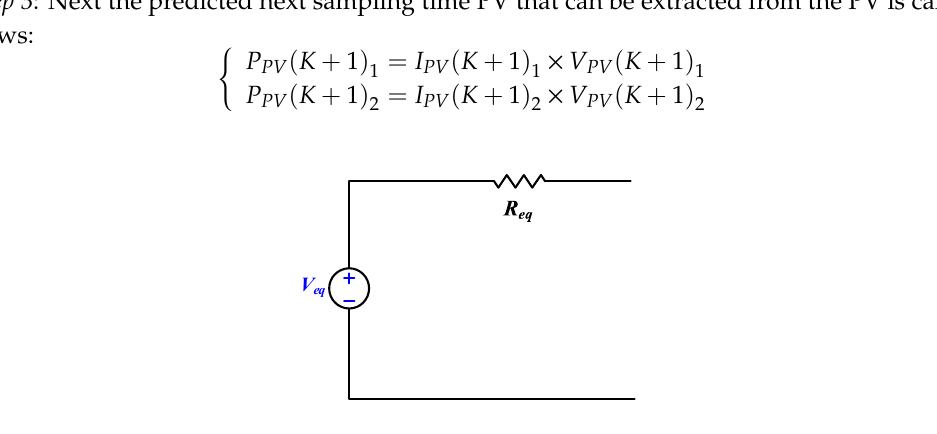
Figure 6. The Thevenin equivalent circuit of the PV module.